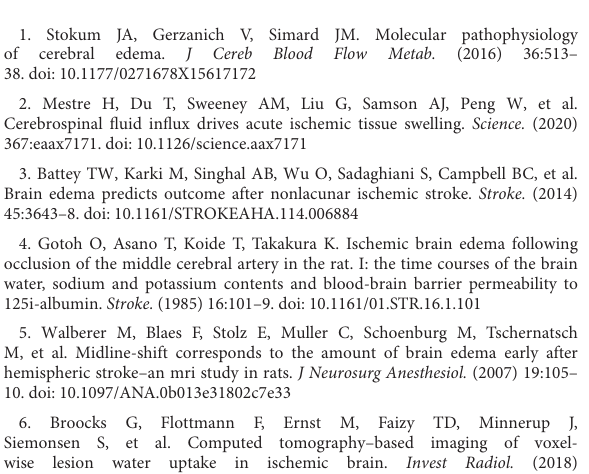
SUPPLEMENTARYTABLE1 Patient’s demographics of group MT vs.